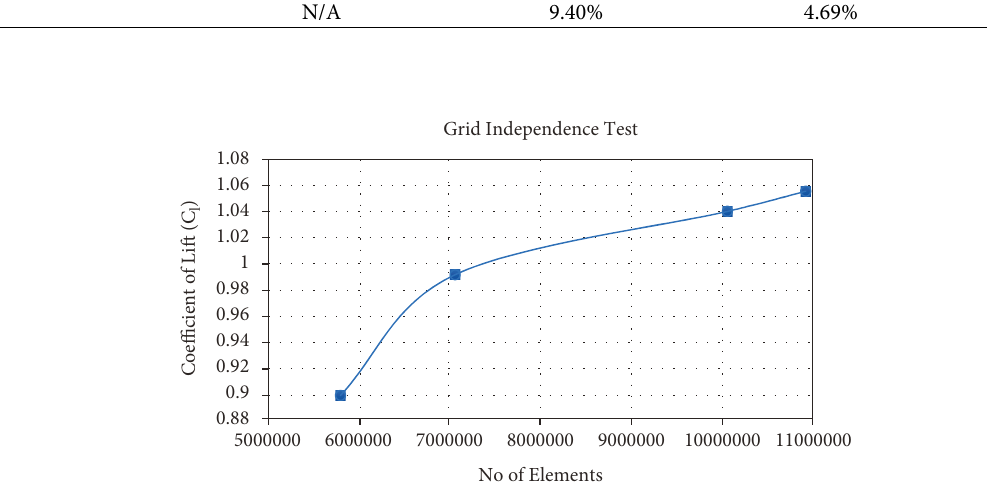
Figure 4: Grid independence test for four-bladed analysis.